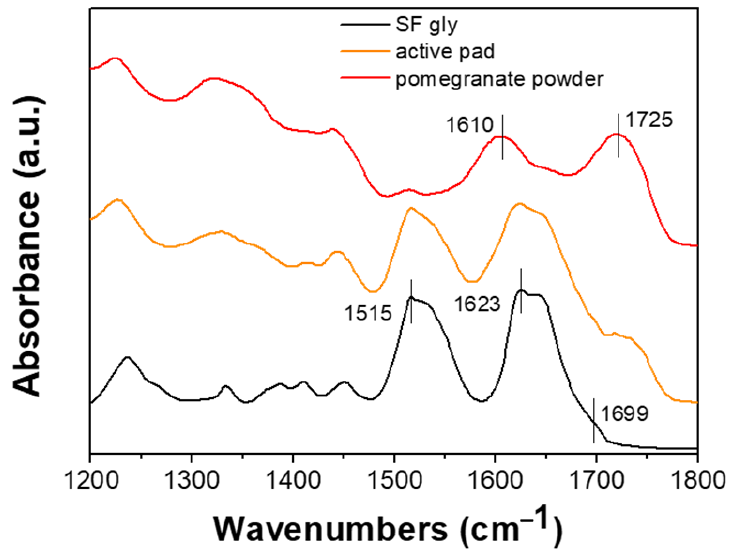
Figure 3. FTIR spectra collected in amide regions (1200–1800 cm − 1 ) of SF gly (black line), active pad (orange line) and pomegranate powder (red